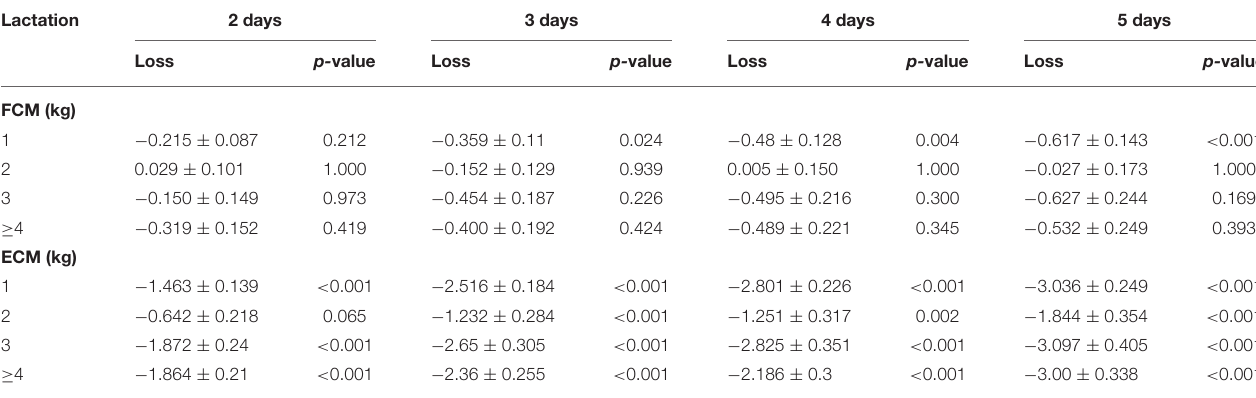
TABLE 3 | Relative variation of fat-corrected milk (FCM) and energy-corrected milk (ECM), after heat waves lasting 2, 3, 4, and 5 consecutive days, compared with the losses estimated after a single day of daily maximum temperature–humidity index (THI) over the threshold, for the different parity classes. Lactation 2 days